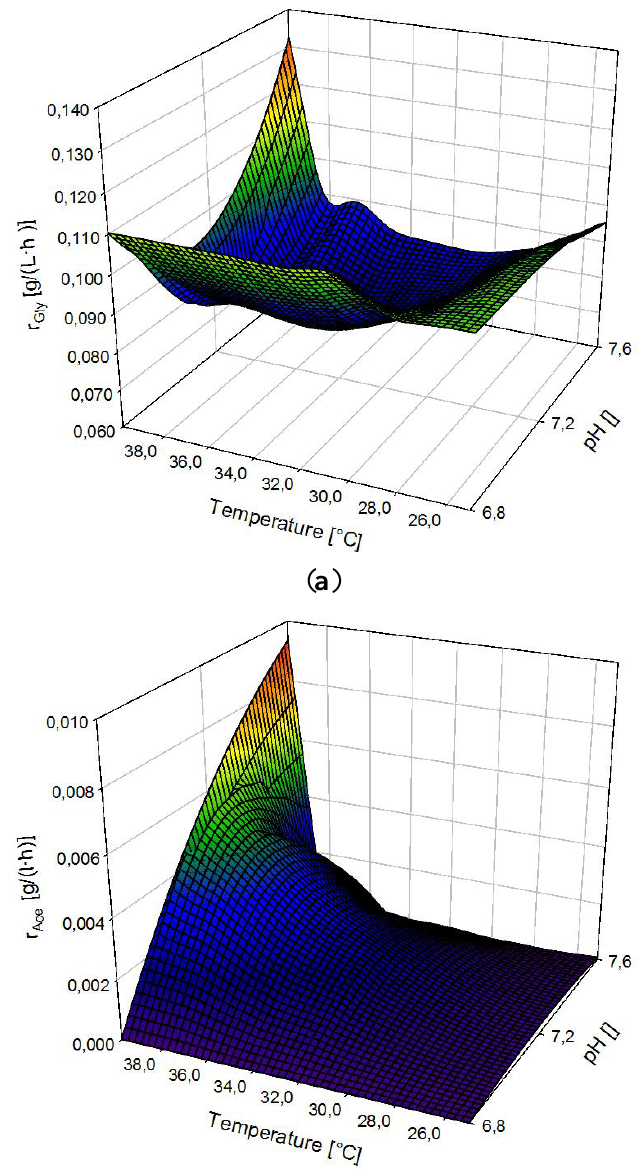
temperature for temperature ramp up 1. ( b ) The dependency of the acetate production dependency of the biomass production rate on the process parameters pH and